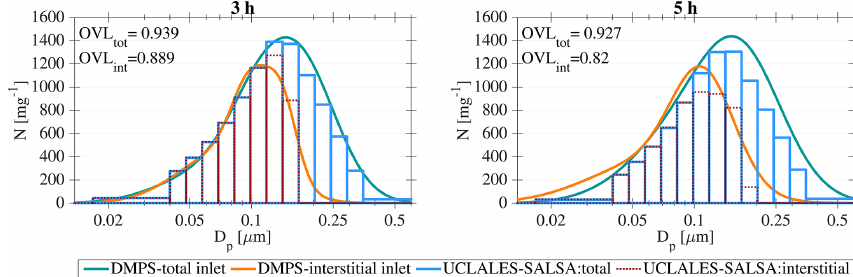
Figure 6. Comparison of aerosol size distributions calculated with UCLALES–SALSA at Puijo altitude of 225m and measured by the twin-inlet DMPS system during case 1, 24 September 2020.